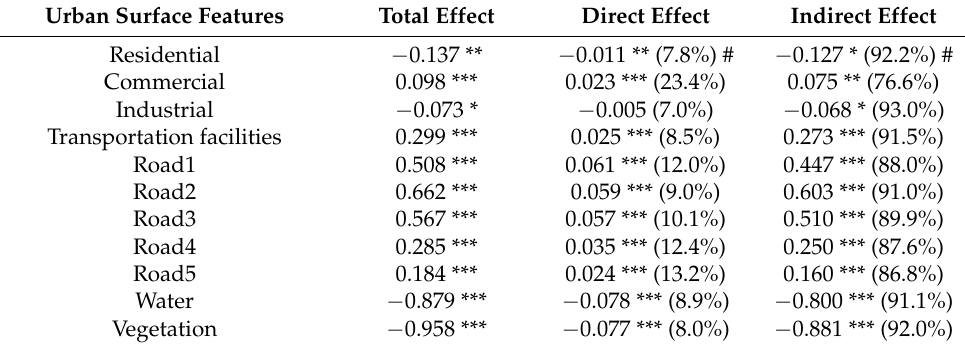
Table 5. Contributions of different urban surface features to Luojia 1-01